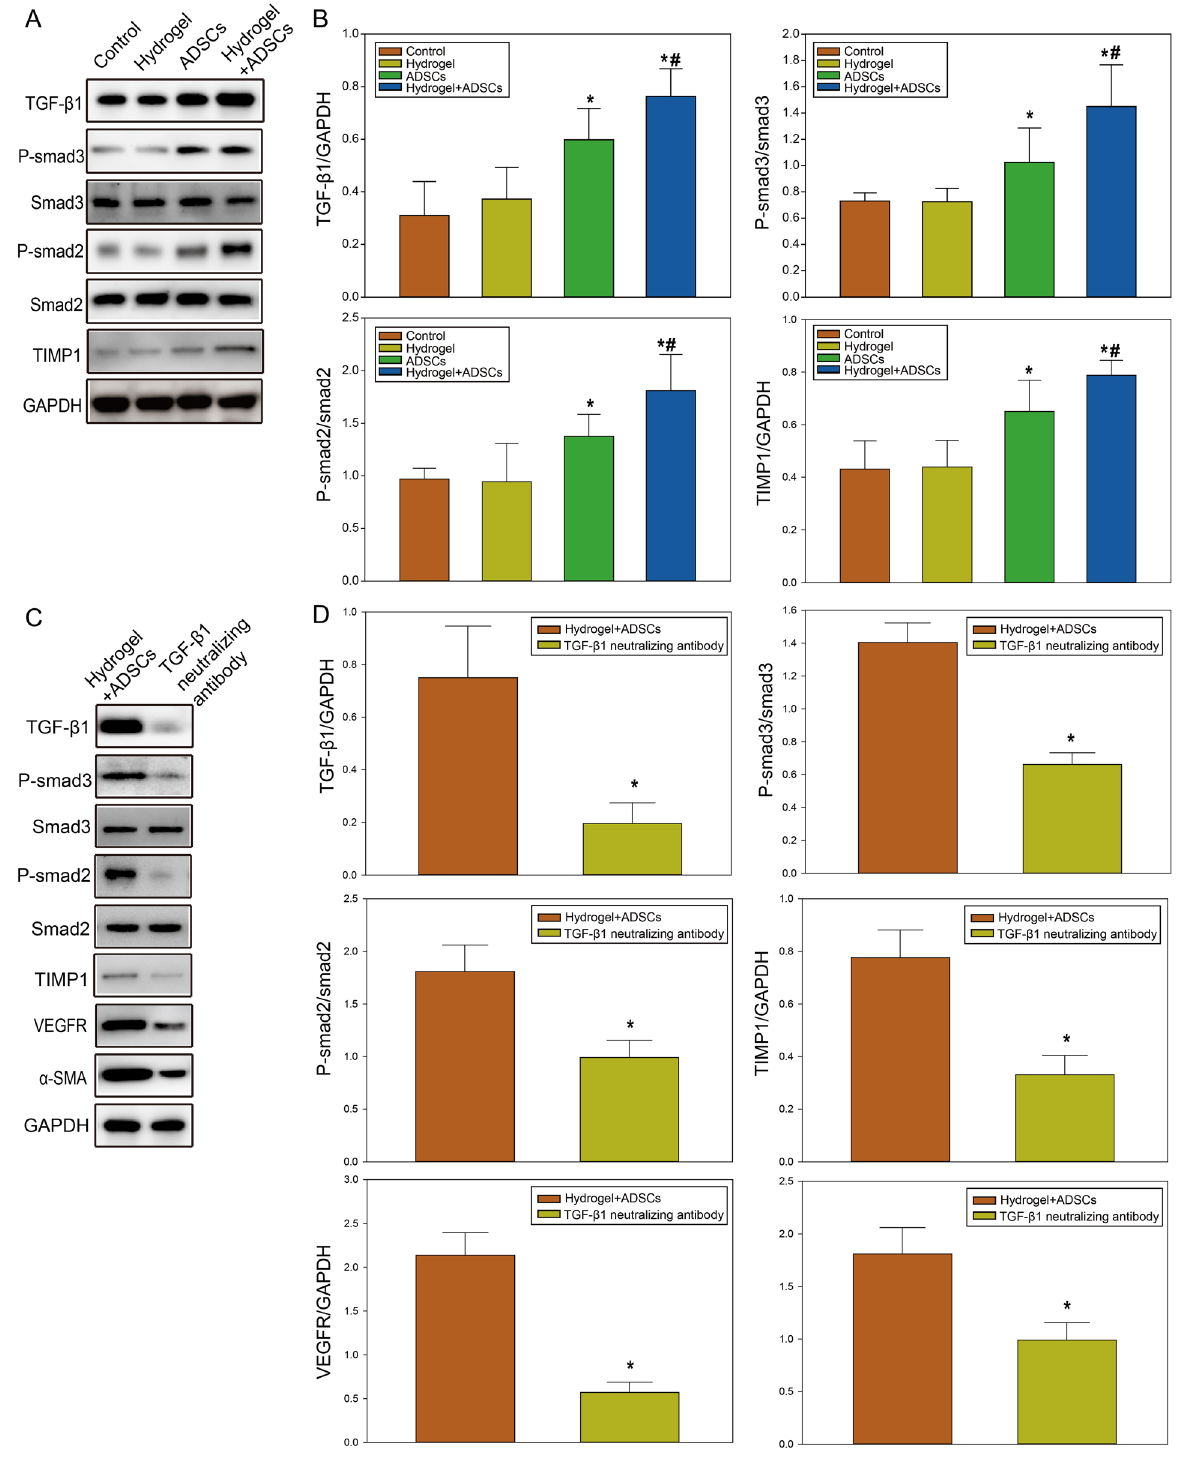
Fig. 6 ADSCs-loaded β -ChNF hydrogel regulated the TGF β /smad3 signaling pathway. A Representative western blot images of TGF β 1, P-smad3, smad3, P-smad2, smad2, TIMP1, and GAPDH. B Quantitative analysis of TGF β 1, P-smad3, smad3, P-smad2, smad2, and TIMP1. Results are expressed as the mean ± SD. * P < 0.05, vs. the control group; # P < 0.05, vs. the ADSCs group; & P < 0.05, vs. the ADSCs + hydrogel group. C Representative western blot images of TGF β 1, P-smad3, smad3, P-smad2, smad2, TIMP1, and GAPDH after treatment with neutralizing antibody. D Quantitative analysis of TGF β 1, P-smad3, smad3, P-smad2, smad2, and TIMP1 after treatment with neutralizing antibody. Results are expressed as the mean ± SD. * P < 0.05, vs. the control group; # P < 0.05, vs. the ADSCs group; & P < 0.05, vs. the ADSCs + hydrogel